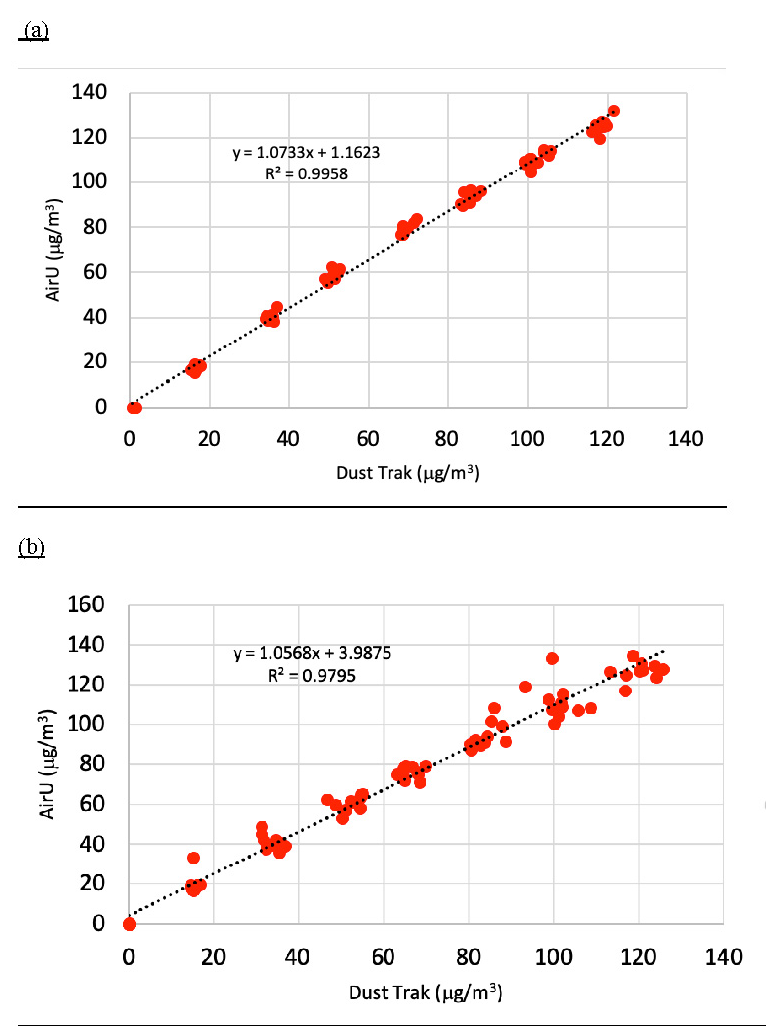
Figure 2. Changes in calibration equation in a single represent AirU. ( a ) is the pre-calibration equa- tion and ( b ) is a post-calibration equation after 189 days in